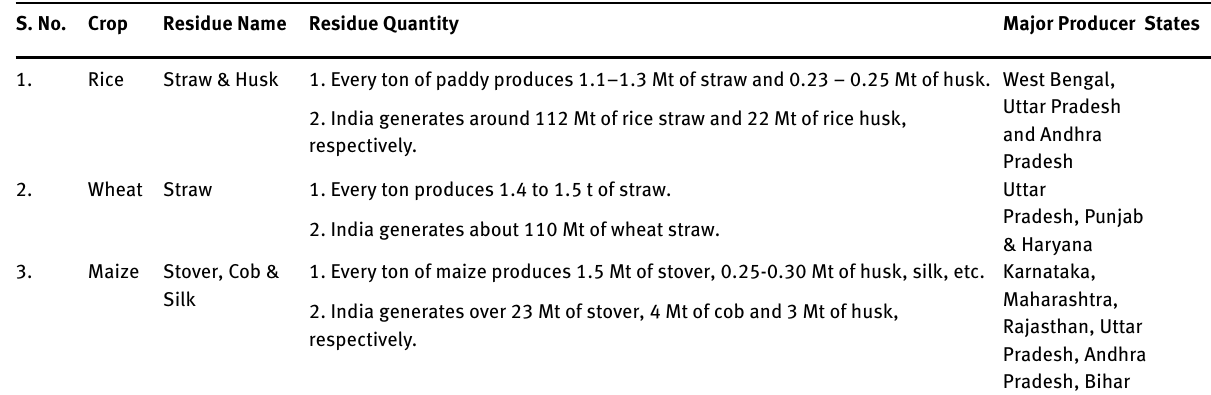
Table 4: Biomass residue sources and quantity of rice, wheat and maize S. No.